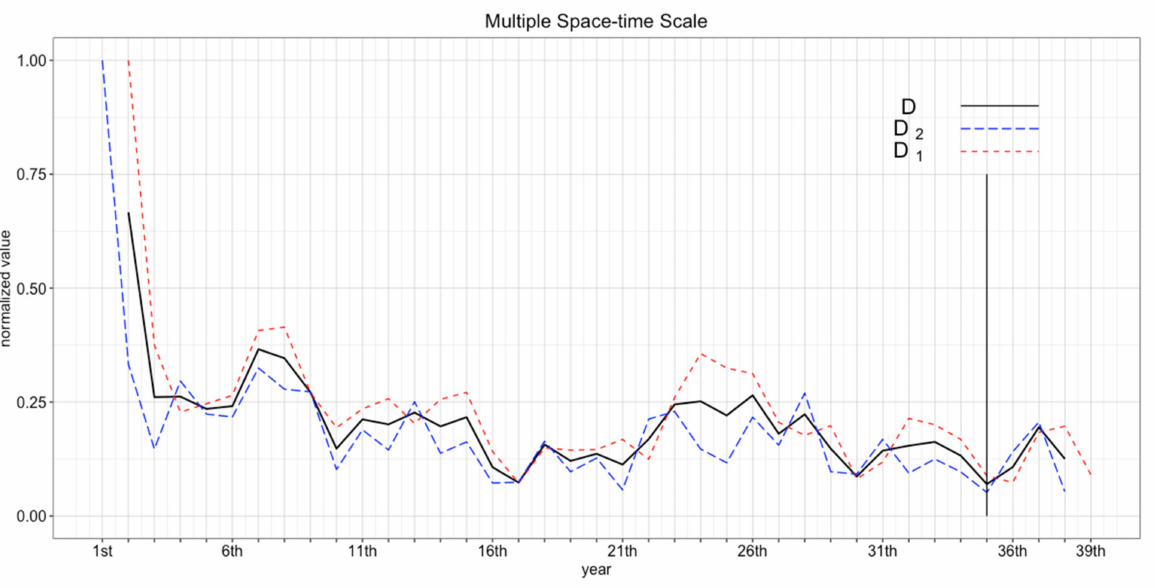
Figure 13. D , D 1 , and D 2 over simulation